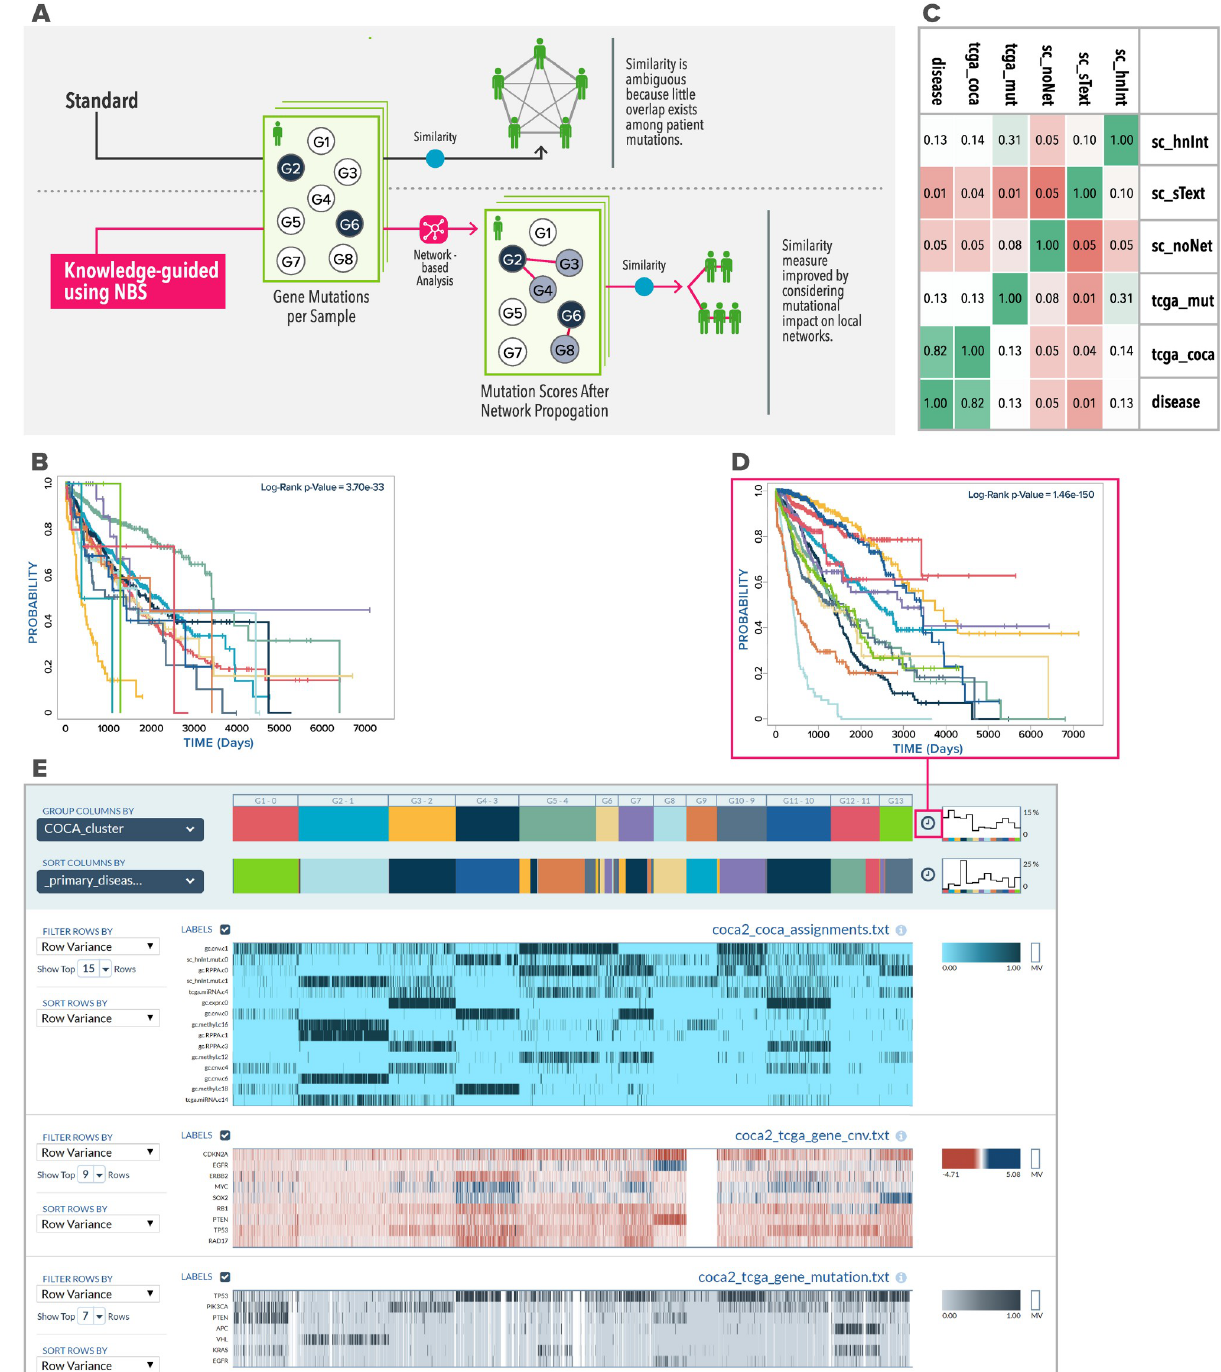
Fig 3. Knowledge-guided sample clustering. (A) Knowledge-guided sample clustering, illustrated in the context of somatic mutation profiles of cancer patients. Because mutations are rare, 2 patients may not have mutations to the same gene(s), and their mutual similarity will be modest. In the knowledge-guided mode (bottom), similarities between patient profiles are detected if not only the same genes are mutated but also if genes located proximally on a network are mutated; this “relaxed” notion of mutation profile similarity leads to improved clustering. (B) Kaplan-Meier survival analysis of clusters from HumanNet-guided clustering of somatic mutation profiles. Each of 14 reported clusters is plotted as a separate survival curve, and the p -value of the multivariate log-rank test is displayed. (C) Concordance between different clustering approaches, using ARI. Three of these approaches use the Sample Clustering (sc) pipeline, with HumanNet (hnNet), STRING text mining (sText) or no network (noNet) for guidance. Two